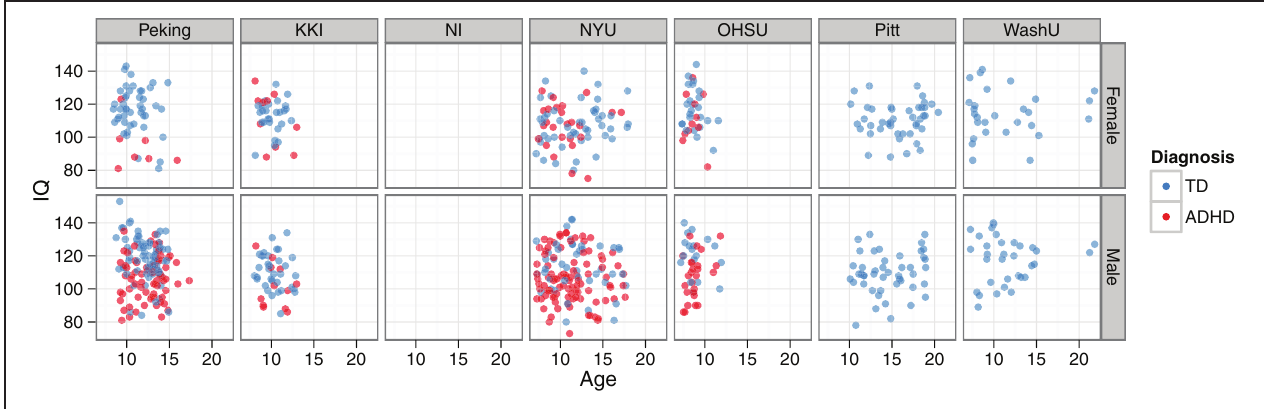
FIGURE 6 | IQ vs. age, by diagnosis, site, and gender. Demographics data are plotted for the training set. The NeuroIMAGE site had no IQ data, and the Pittsburgh and Washington University sites only had TD cases. The bottom left panel corresponds to the example data used in Figure 2 .